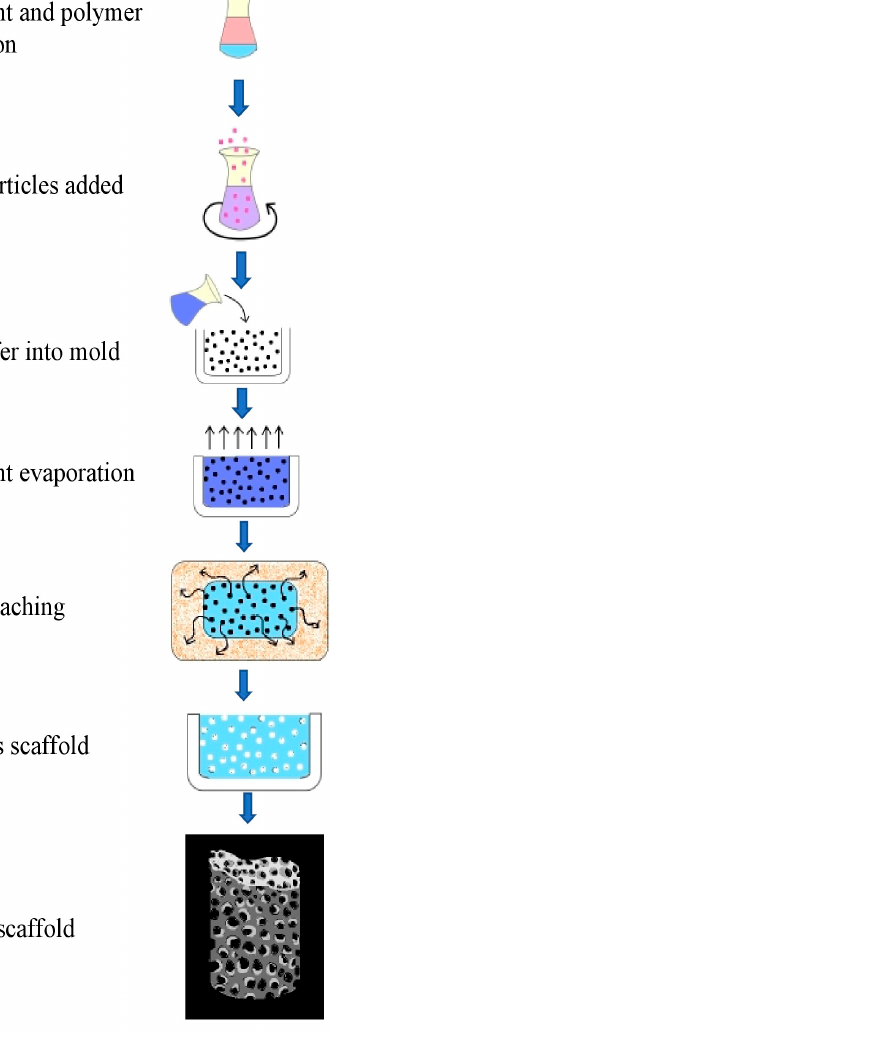
Figure 6. Schematic representation for designing bone scaffolds with hierarchical structures for bone regeneration using solvent casting particle leaching (SCPL) method.